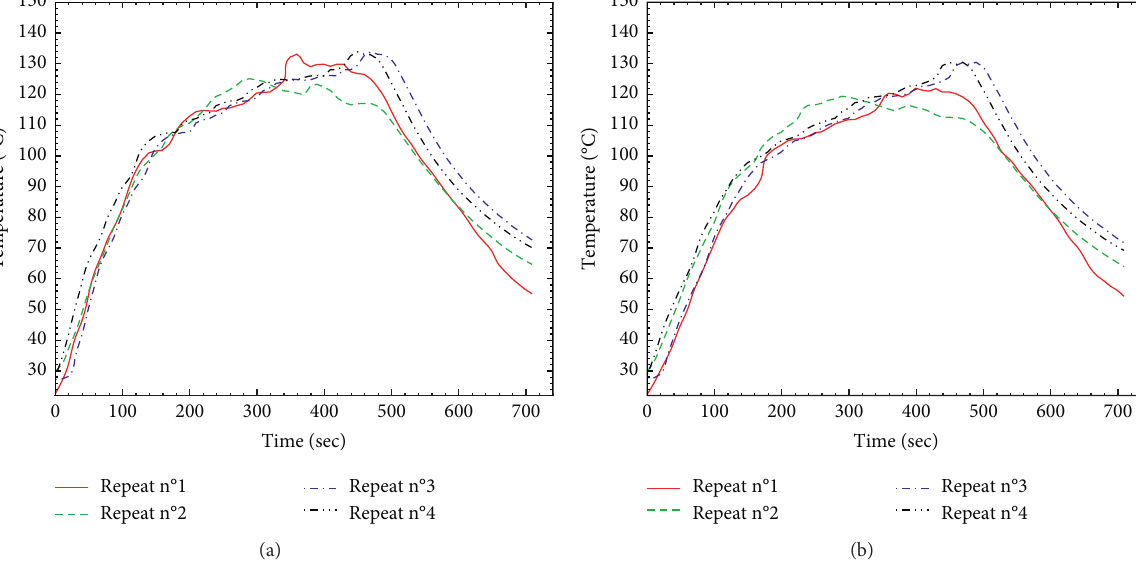
Figure 10: (a) Temperature profiles of TH1 plotted during tests in the PFO configuration. (b) Temperature profiles of TH3 plotted during tests in the PFO